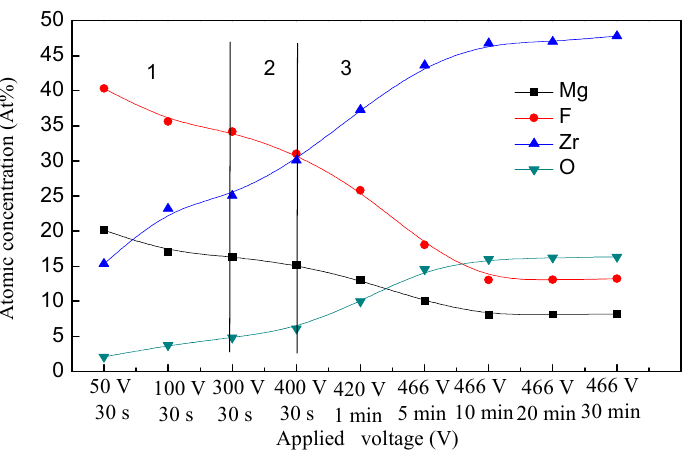
Figure 7. Qualitative analysis of element concentration in the oxide membranes formed at different PEO reaction stages.